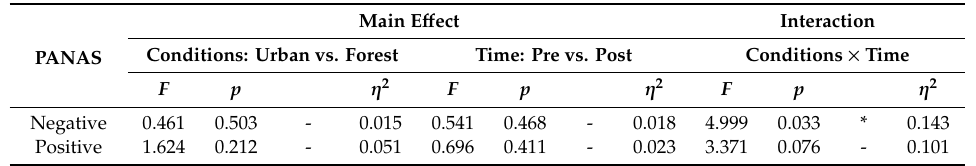
Table 5. Results for mixed-model ANOVAs investigating Positive and Negative A ff ect Schedule States (PANAS) scores. Main E ff ect Interaction Conditions: Urban vs. Forest Time: Pre vs. Post PANAS